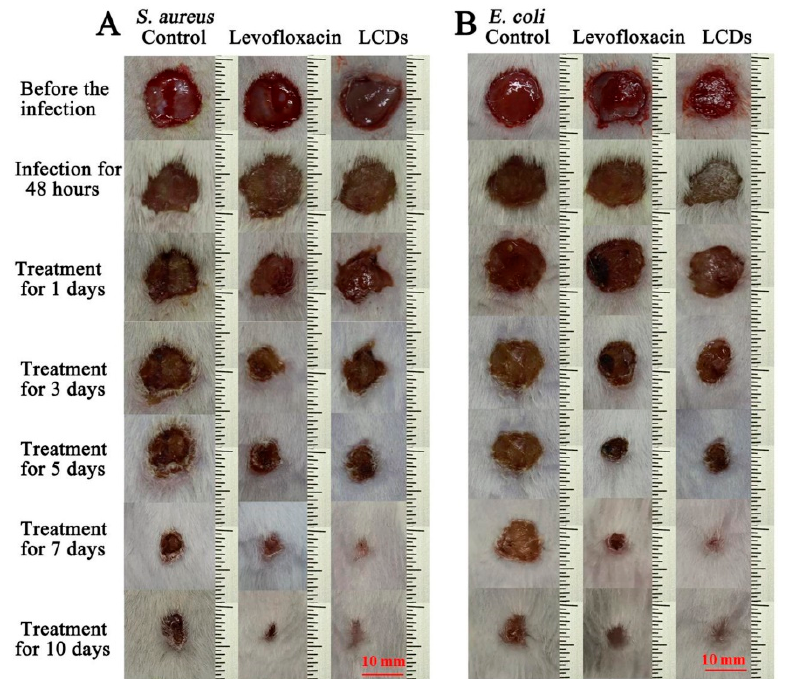
Figure 12. Photographic images of the wound healing progress (1 to 10 days) of ( A ) the infected wounds with S. aureus and ( B ) infected wounds with E. coli treatment with normal saline, LC-HCl, and LCDs(reprinted with permission from [157], 2022, Elsevier).